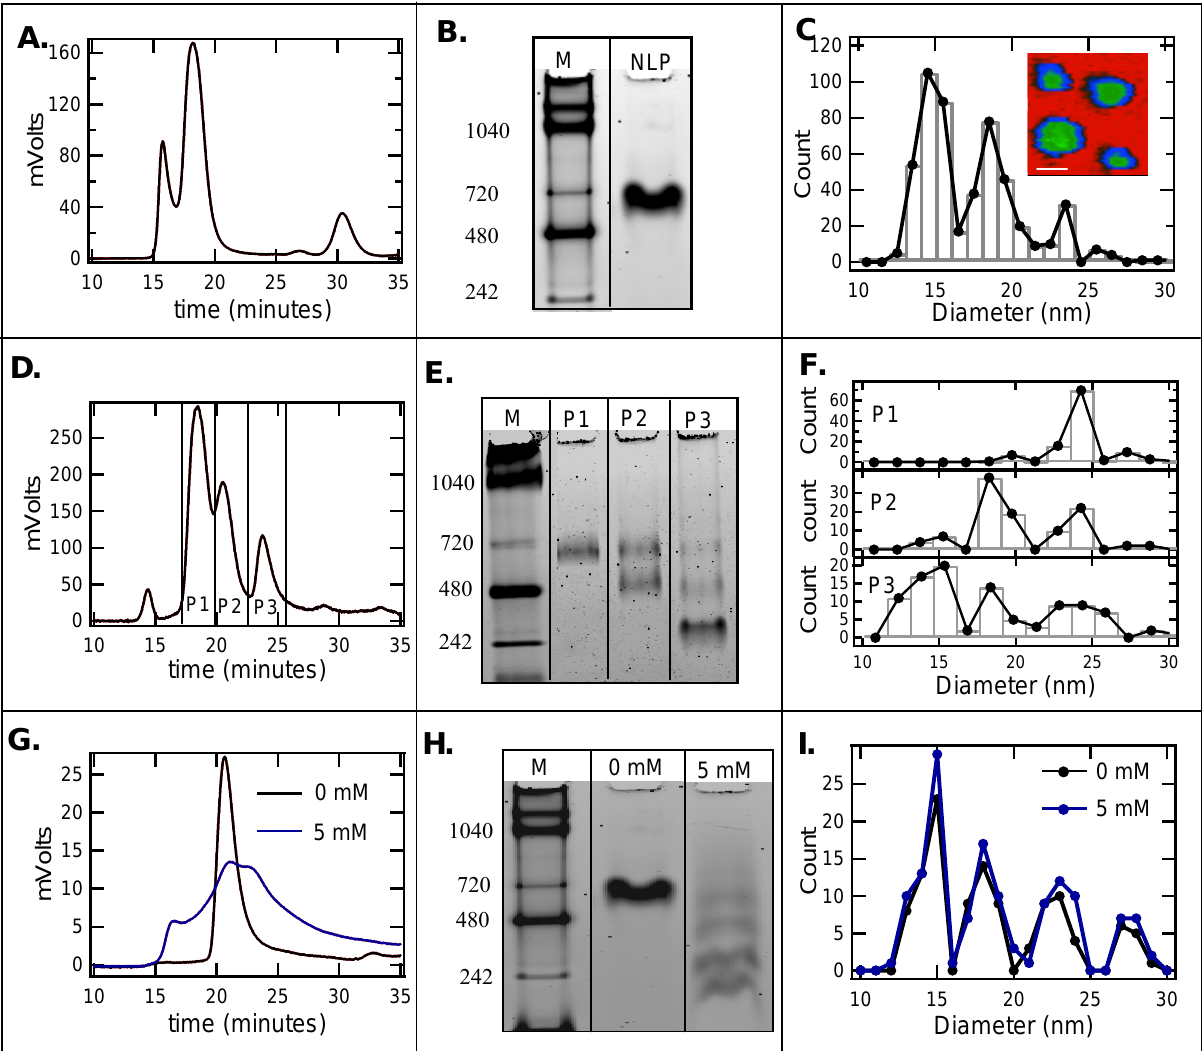
Figure 1. Effect of cholate on NLP size as characterized by SEC, Native gel electrophoresis, and AFM. A. SEC trace, B. Native gel electrophoresis and C. AFM image analysis of NLPs assembled using the cholate-free method. Inset AFM image of the four predominant NLP sizes. Scale bar 25 nm. D. SEC trace, E. Native gel electrophoresis, and F. AFM image analysis of NLPs assembled using the cholate-associated method. G. SEC trace, H. Native gel electrophoresis, and I. AFM image analysis of NLPs assembled using the cholate-associated method in the presence of 0 mM and 5 mM cholate. In G. and I. black line – 0 mM cholate, blue line – 5mM